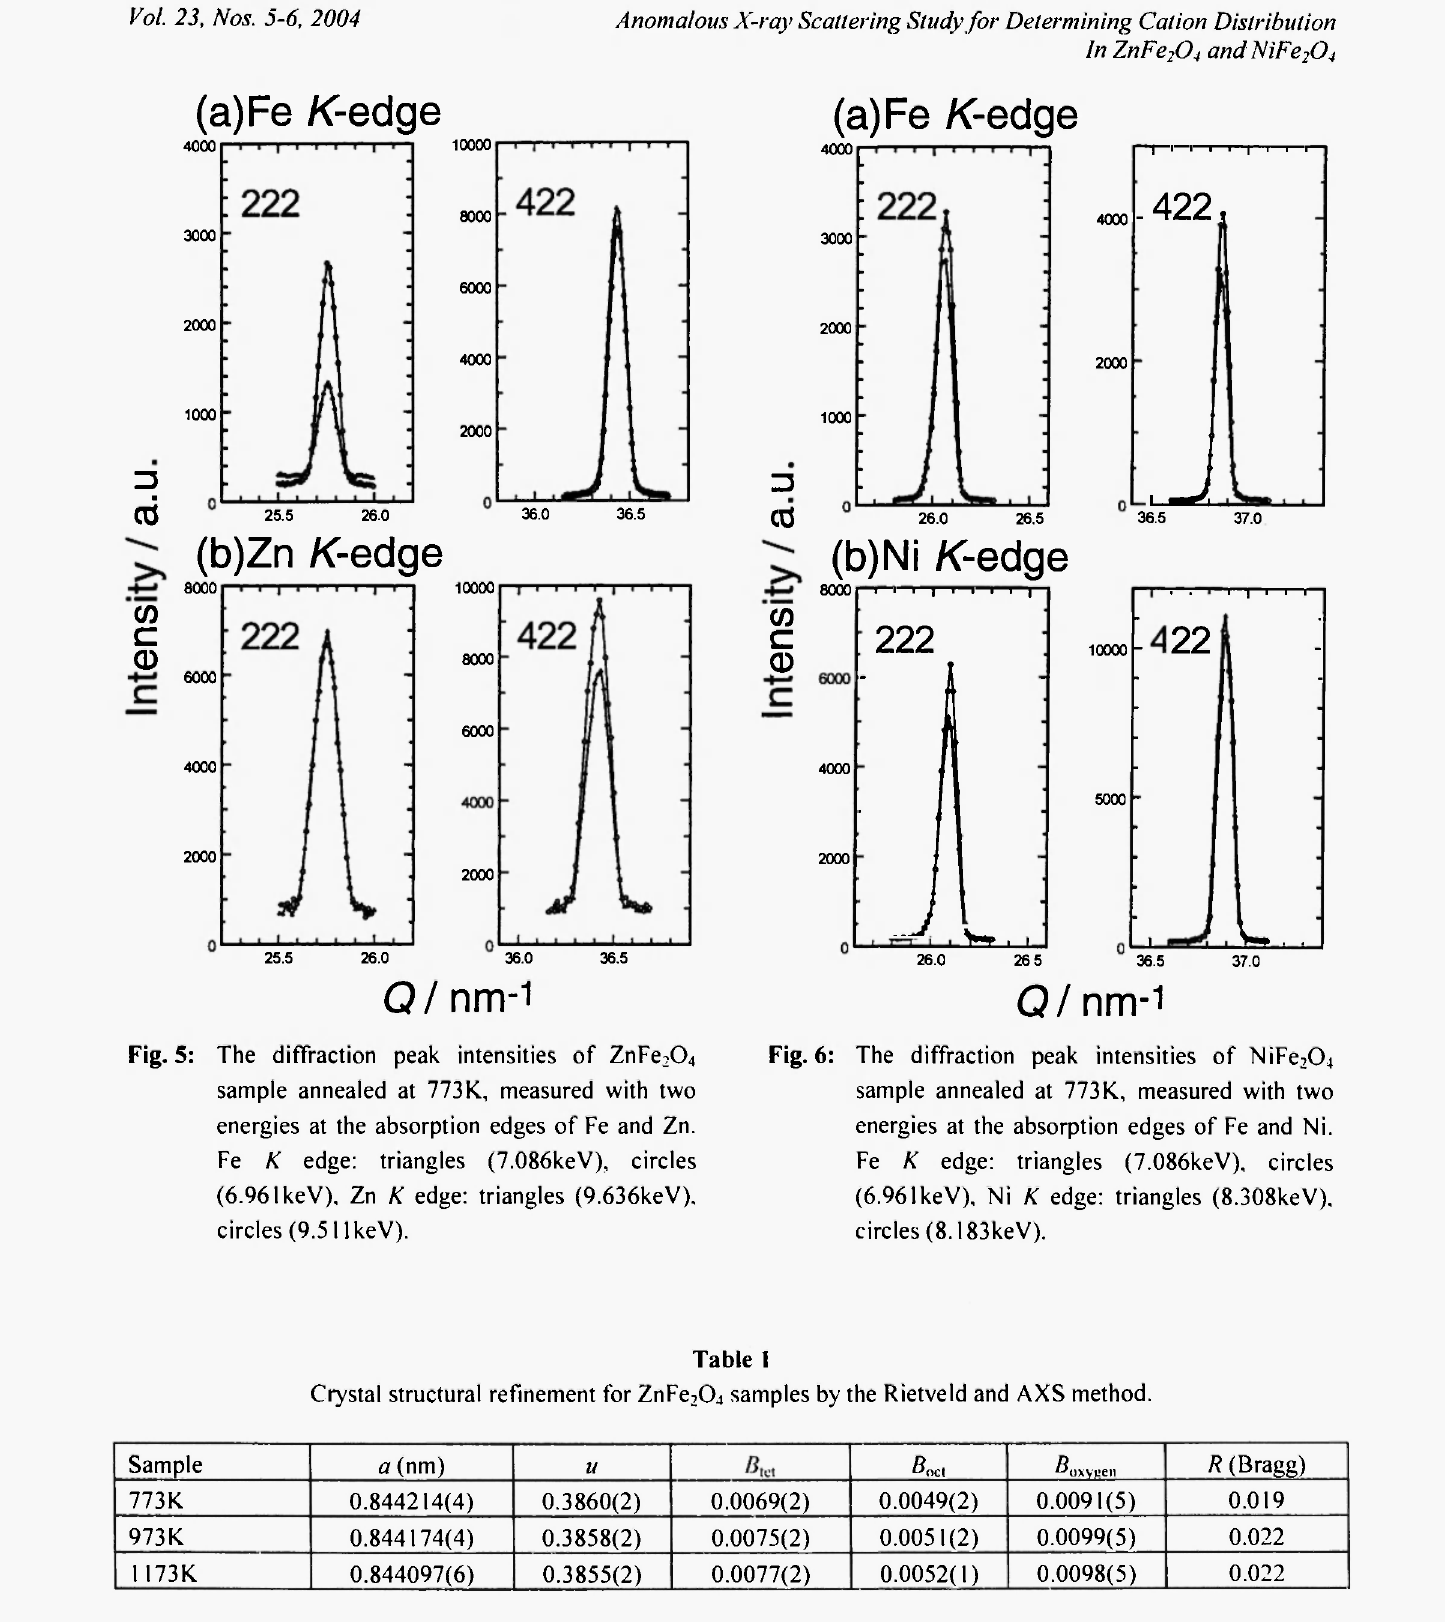
Fig. 5: The diffraction peak intensities of ZnFe 2 04 sample annealed at 773K, measured with two energies at the absorption edges of Fe and Zn. Fe Κ edge: triangles (7.086keV), circles (6.961 keV), Zn Κ edge: triangles (9.636keV). circles (9.51 IkeV).